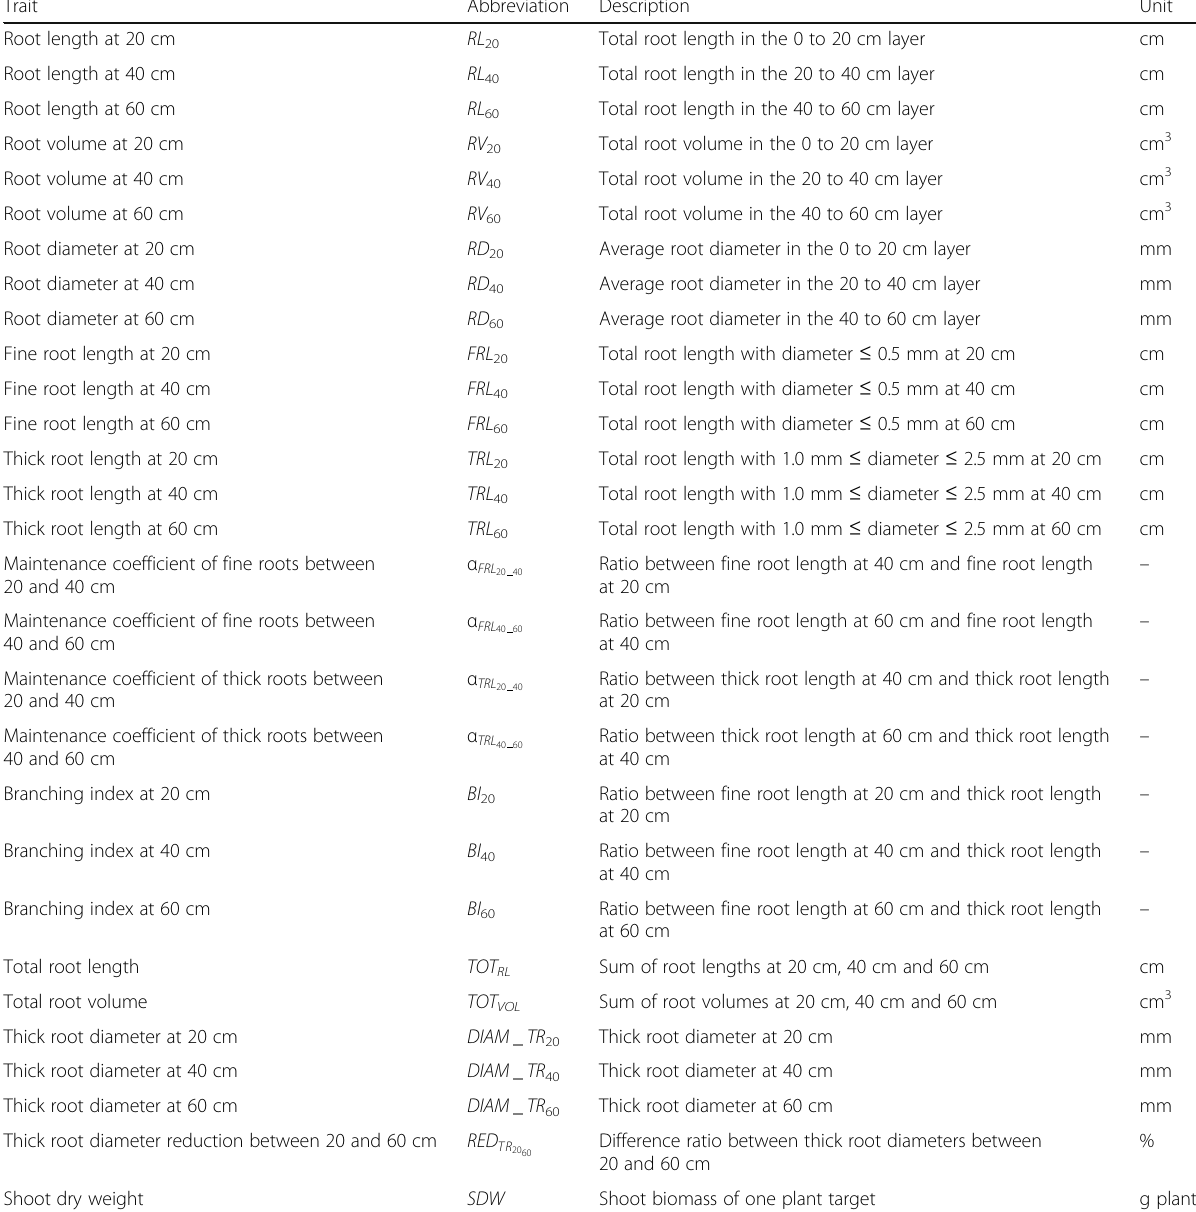
Table 1 Description of measured traits in the tropical japonica rice panel grown in greenhouse Trait